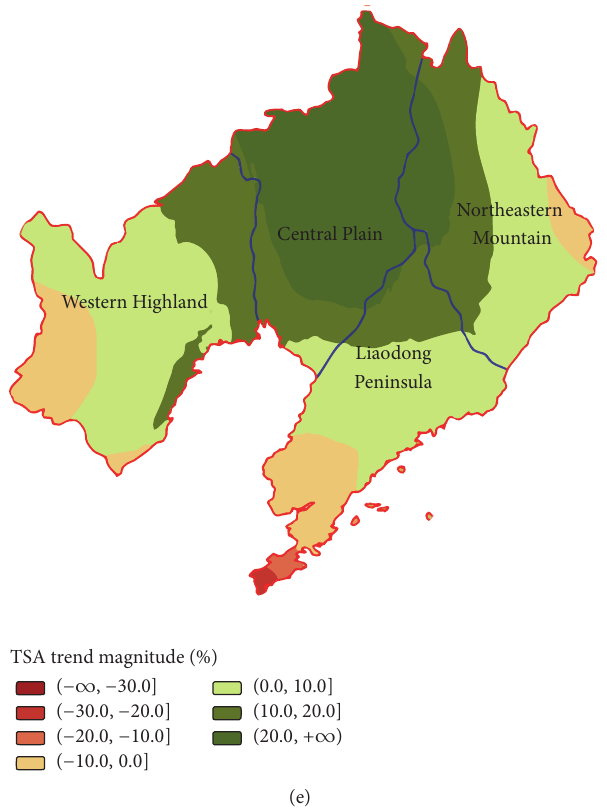
Figure 5: Spatial distribution patterns of relative precipitation variation (as a percentage of the mean annual or seasonal precipitation) over the 47-year period at annual and seasonal time scales: (a) annual, (b) spring, (c) summer, (d) autumn, and (e) winter precipitation. Theil-Sen’s estimator (TSA, Theil-Sen approach) is used to quantify the magnitude of trends.